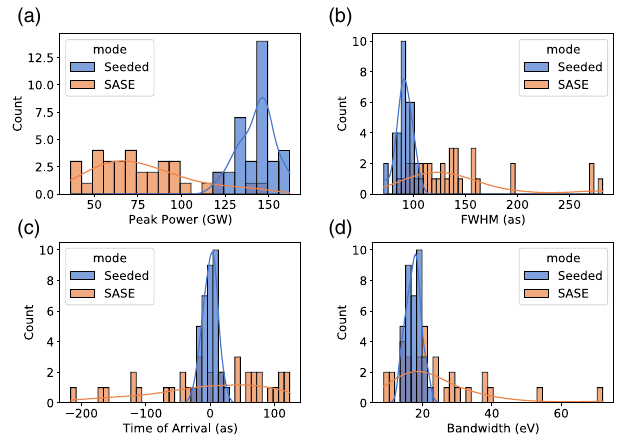
FIG. 12. Comparison of stability between ESASE and seeded attosecond pulses ’ properties: the histogram of 30 shots for x-ray peak power (a), full-width half-maximum pulse duration (b), time of arrival (c), and spectral bandwidth (d) from SASE (orange) and seeded mode (blue),